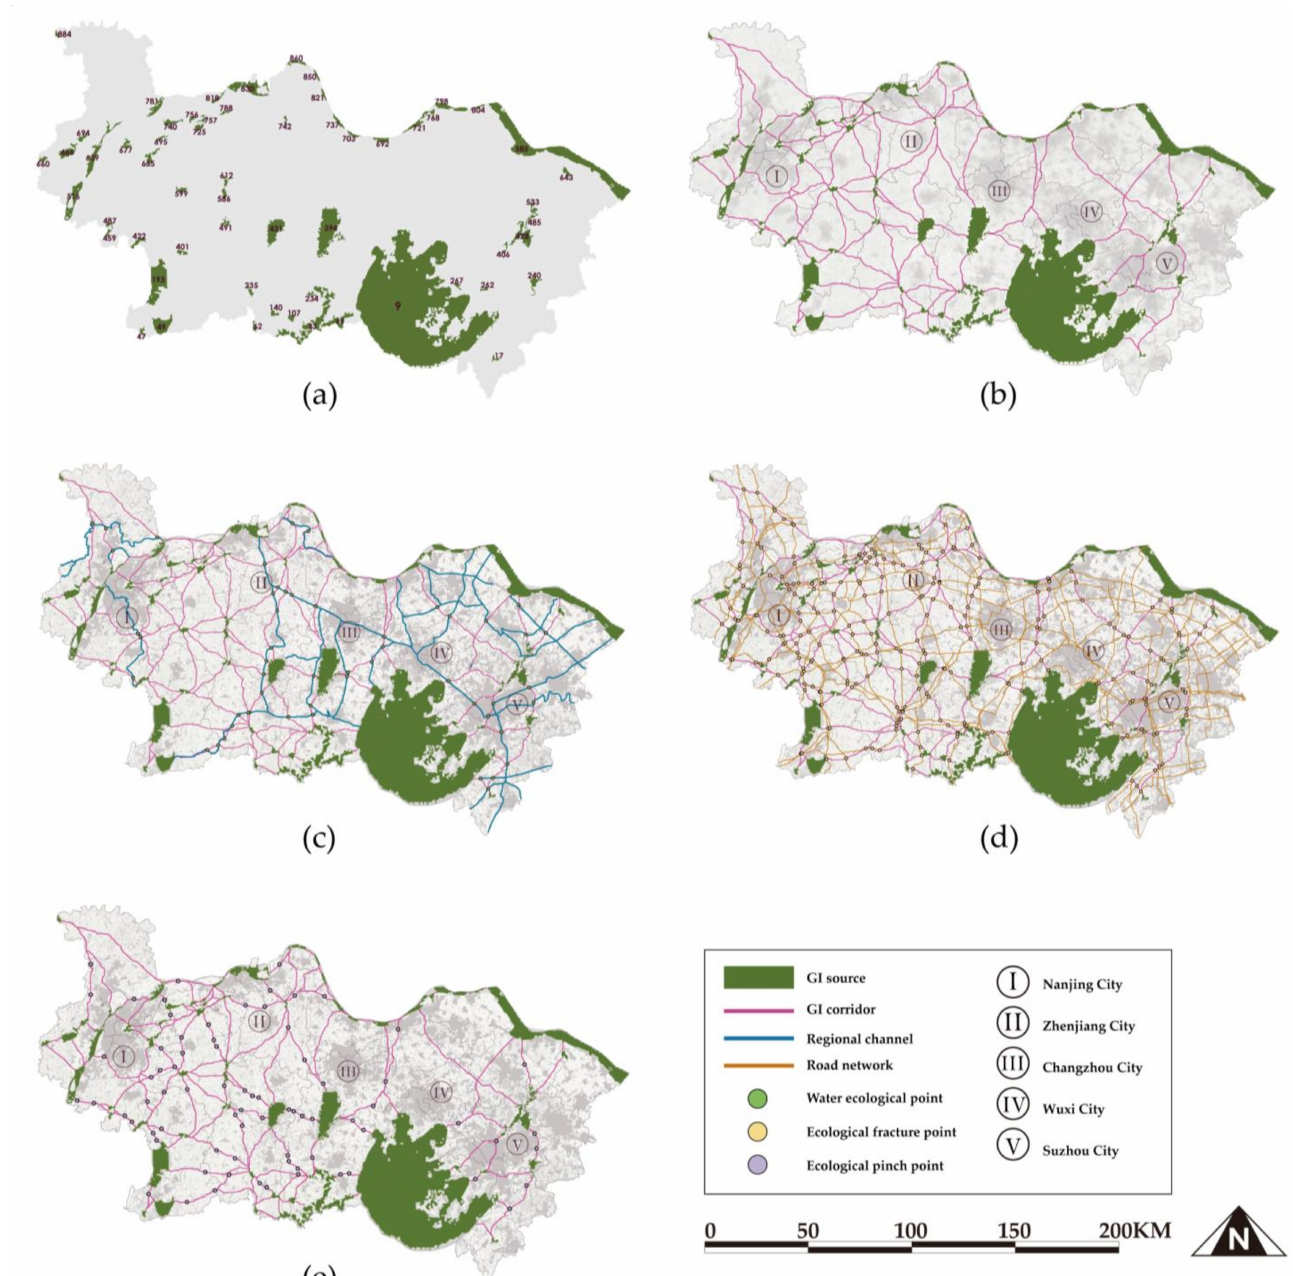
Figure 2. GI key sites identification process: ( a ) GI sources extraction; ( b ) GI corridors construction; ( c ) water ecological points identification; ( d ) ecological fracture points identification; ( e ) ecological pinch points